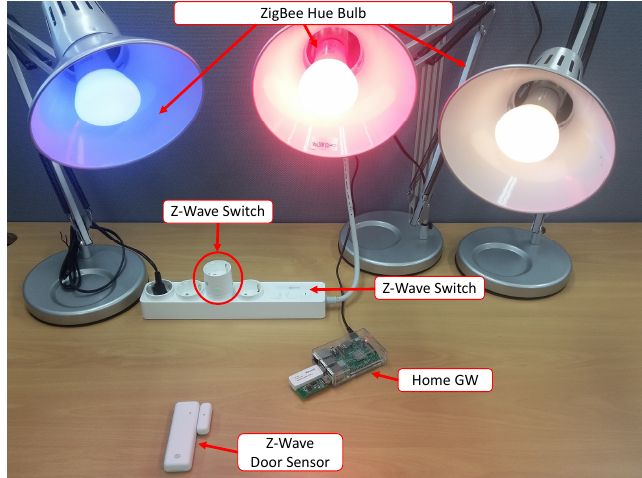
Figure 5. Smart home testbed with Gateway, ZigBee, and Z-Wave smart